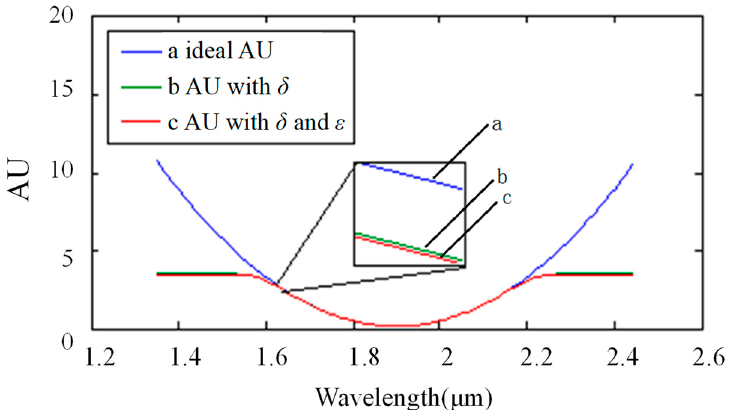
Figure 10. Result of stray light on the absorbance in Hadamard multiple-stripe mode: the horizontal ordinate shows the wavelength with units of micrometers. The longitudinal coordinate shows absorbance, which was represented by “AU” in this paper. Curve a shows the ideal absorbance, curve b shows the absorbance with the noise of variable stray light, and curve c shows the absorbance with the noise of two types of stray light, including variable stray light and intrinsic stray light.